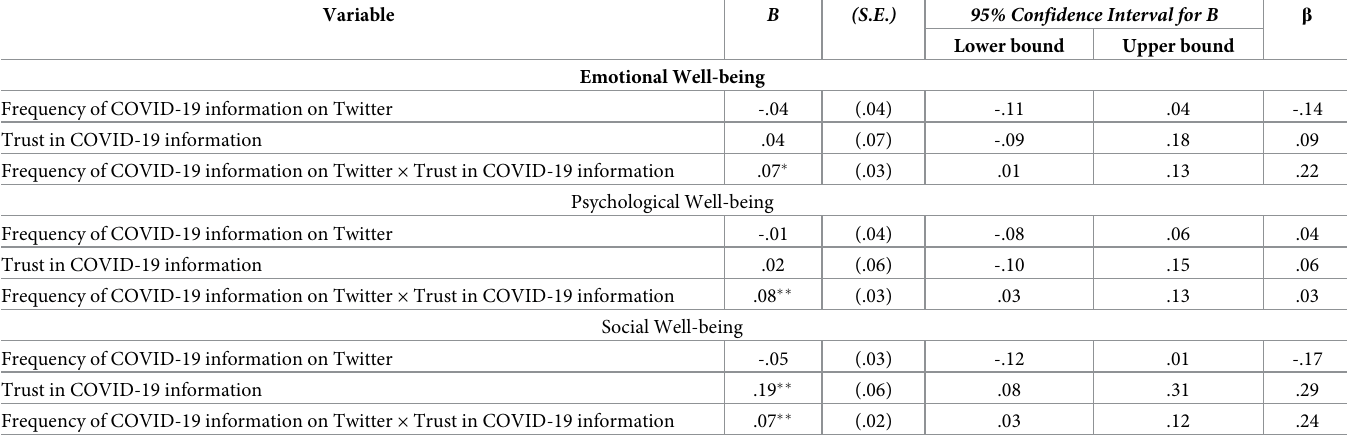
Table 4. Estimates for the main effects and interaction effects of frequency of COVID-19 information on Twitter and trust in COVID-19 information on well-